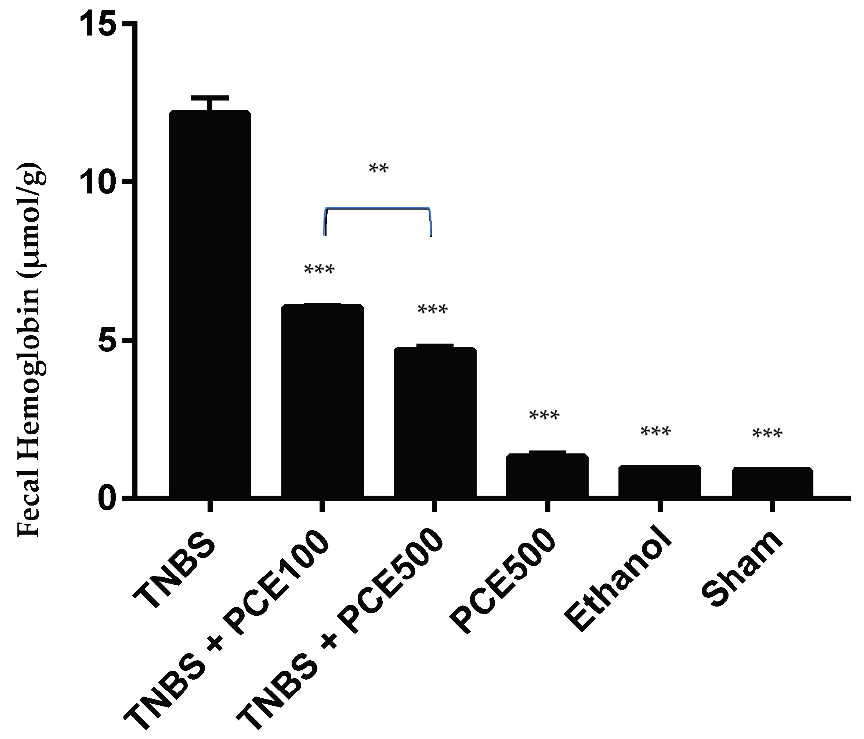
Figure 3. Effect of PCE treatment on fecal hemoglobin in the IBD. The results are represented as mean ± SD [ n (TNBS + PCE100) = 10; n (TNBS + PCE500) = 10; n (PCE) = 10; n (TNBS) = 6; n (Ethanol) = 5; n (Sham) = 5; ** p < 0.01; *** p < 0.001 compared with TNBS group, one-way ANOVA followed by Tukey’s post hoc test]. Abbreviations: IBD, inflammatory bowel disease; PCE, phenolic compounds extract; TNBS, 2,4,6-Trinitrobenzene sulfonic acid.